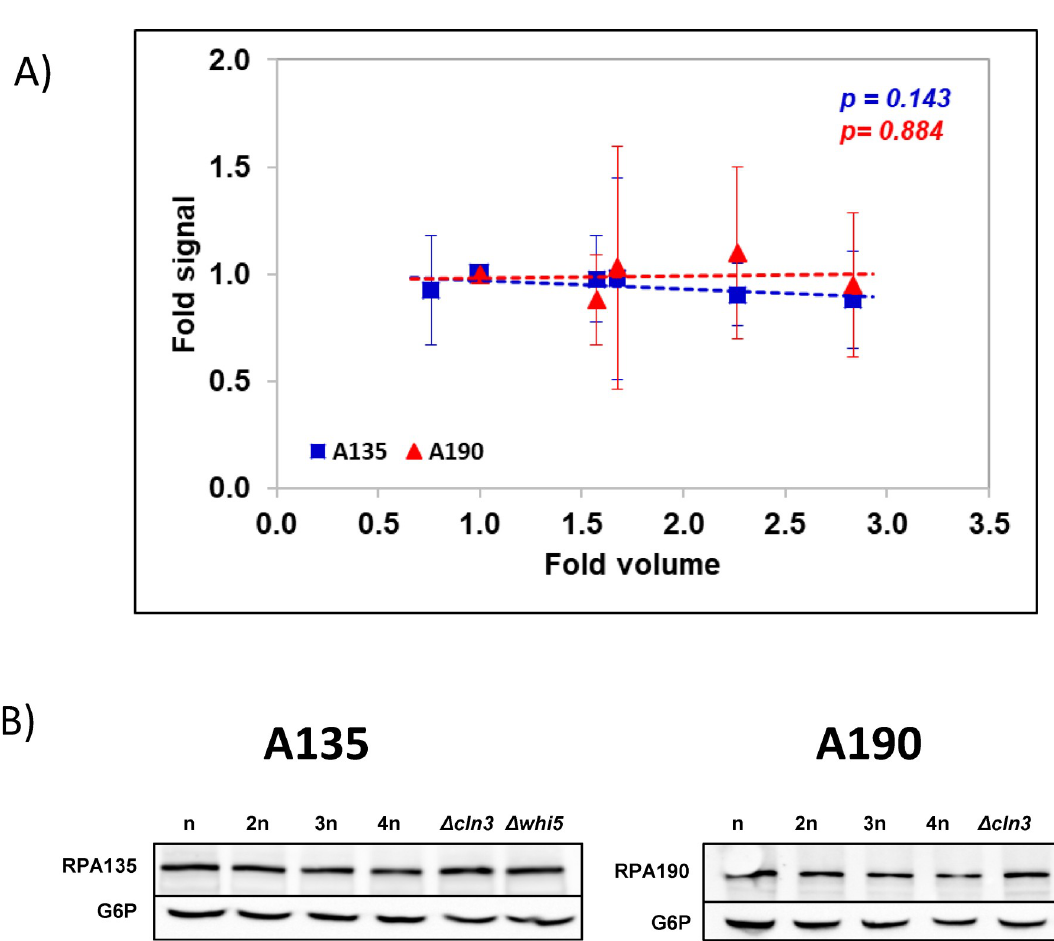
Fig 3. The cellular concentration of RNA pol I does not vary with cell volume. A) The RNA pol I concentration in the different polyploids (n-4n) and haploid mutants ( whi5 , cln3 ) shown in Fig 2A was calculated by Western blot using approximately the same amount of total protein and correcting by the G6P-DH signal. An antibody against the second largest RNA pol I subunit (A135, blue squares) and one against the largest RNA pol I subunit (A190, red triangles) are shown. The graphs (representing the fold change regarding the haploid strain) represent the average and standard deviations of three biological replicates. B) In both cases, an example of a Western blot is shown below. The slopes of the trend lines in panel A) do not significantly deviate from the horizontal according to an F-test (p-values are